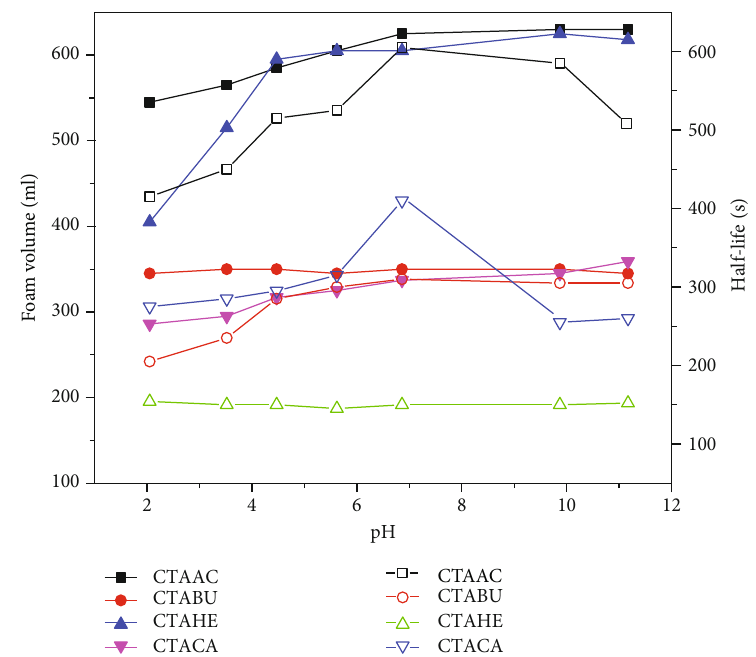
Figure 7: E ff ects of pH on the foam abilities of di ff erent surfactants at room